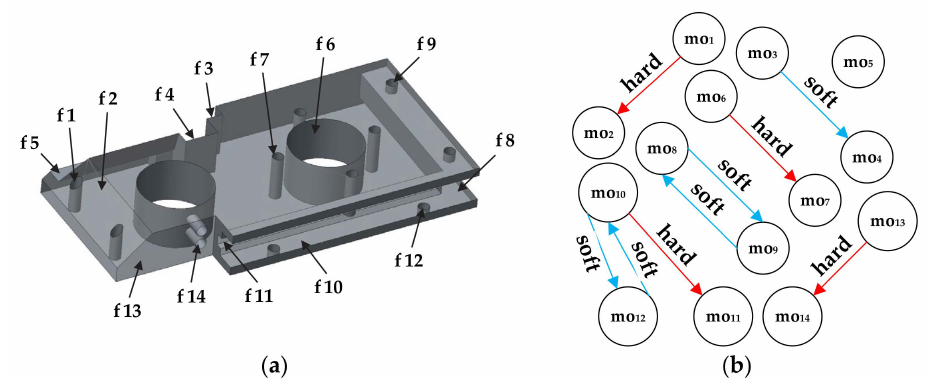
Figure 5. ( a ) Semi-transparent solid model and ( b ) the dOPG of the prismatic part 2.